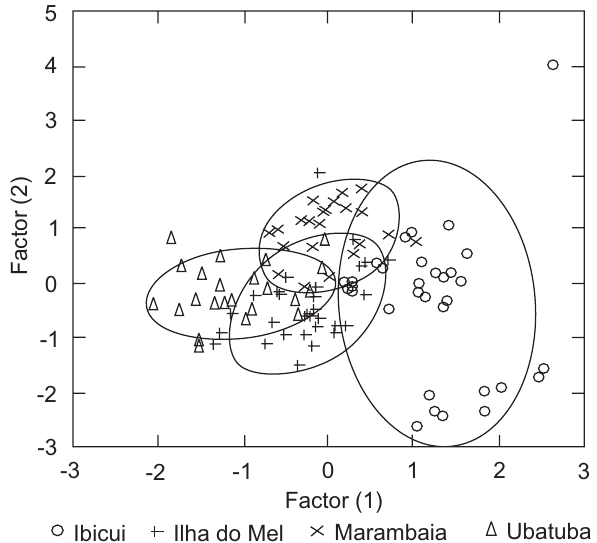
Figure 9. Principal Component Analysis (PCA) for sampled popu- lations of P.